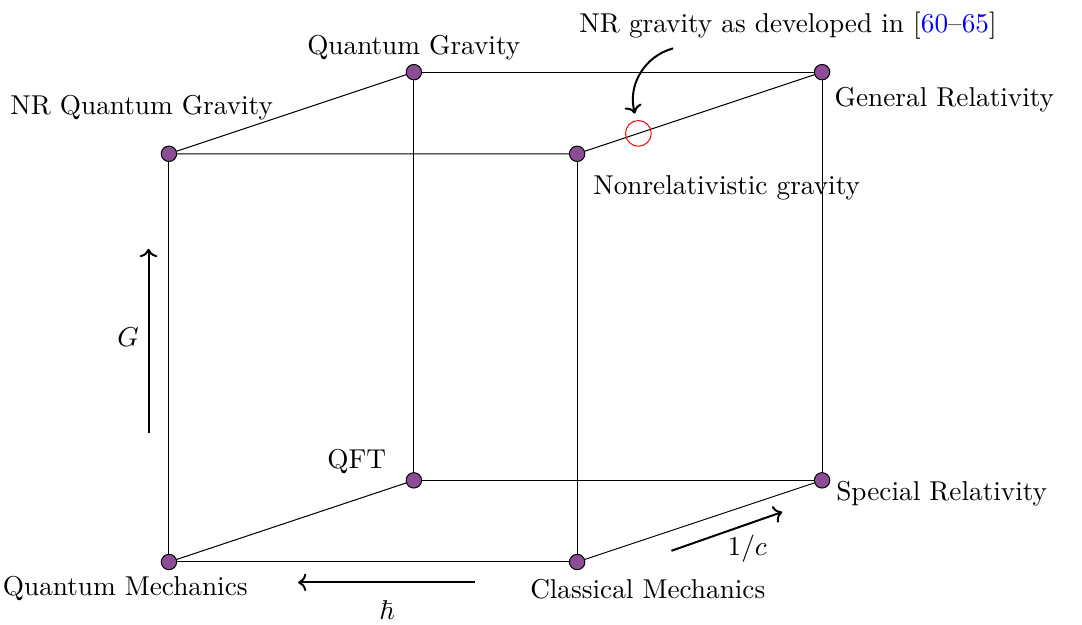
Figure 2 . Bronstein’s cube of physical theories. A perturbative expansion around a vertex takes us along the edges of the cube, which we illustrate for the 1 /c expansion of gravity developed in [60–65]. Nonrelativistic gravity contains Newton-Cartan gravity and thus Newtonian gravity as a special case, but is more general than